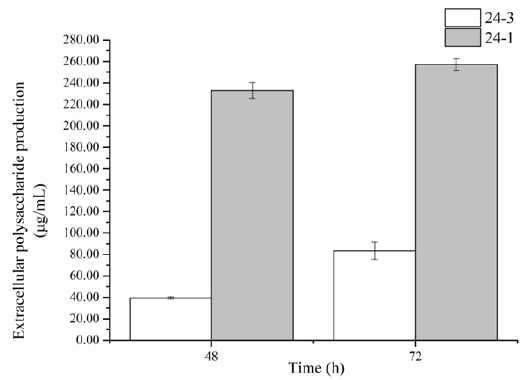
Figure 4. Exopolysaccharide production of strains YL24-3 and YL24-1.